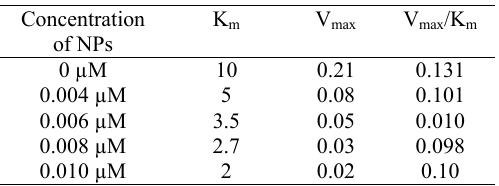
various nano-CuO concentrations at 313 K